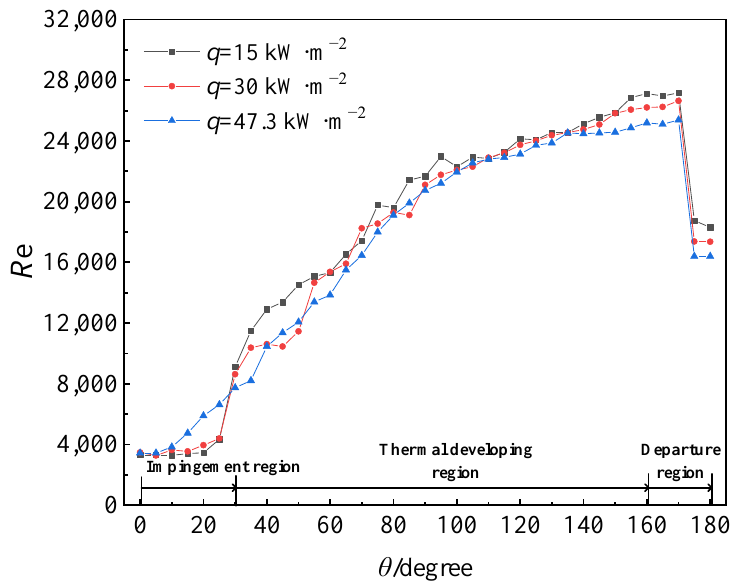
Figure 7. Local Reynolds number around tube under various heat fluxes. The local Nusselt number of mixed solutions drop film flow with different heat fluxes is shown in Figure 8. At the top of the tube, Nu θ is found to increase with increasing heat flux. This is because of the increased temperature gradient in the thermal boundary layer caused by the impact, which results in buoyancy effects and density differences. With the increased heat flux, natural convection in the radial direction is enhanced, resulting in the increase of Nu θ [26]. At the bottom of the tube, the impact effect disappears, and heat transfer by forced convection becomes dominant. The local Nusselt number is usually independent of the heat flux [24]. Therefore, in the thermal developing region, the heat flux does not seem to have a significant effect on Nu θ .